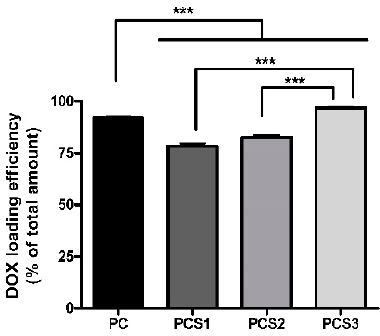
Figure 6. Efficiency of DOX loading into PC, PCS1, PCS2, and PCS3 composite systems. Data are presented as mean values ± SD, and significance was determined at *** p < 0.001 compared to PC DOX loading.